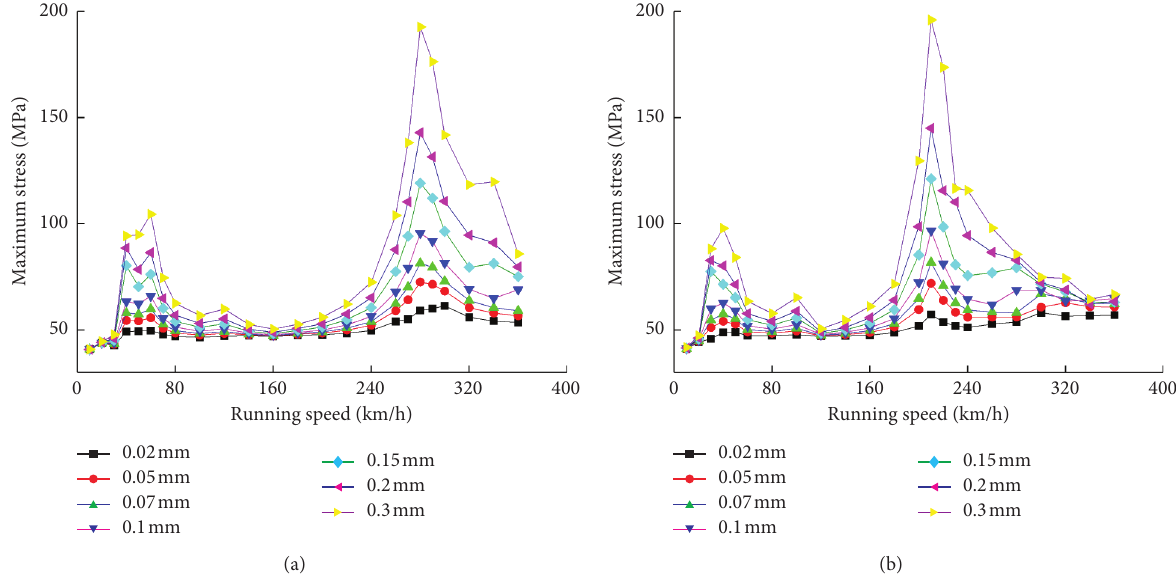
Figure 13: Influence of the wave depth and the running speed on the axle stress. (a) 15 th order polygonal, (b) 20 th order